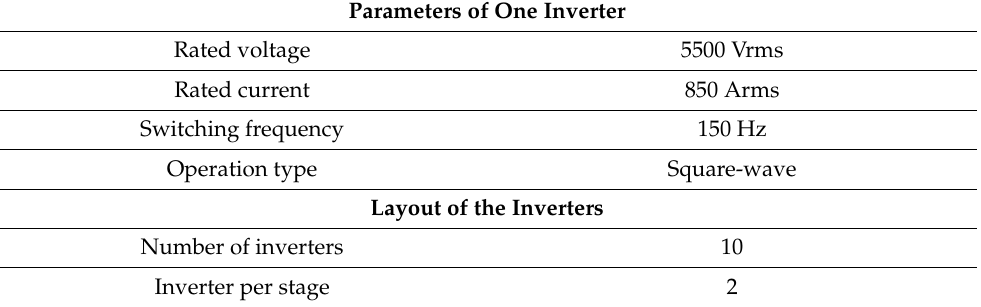
Table 2. Inverters’ main